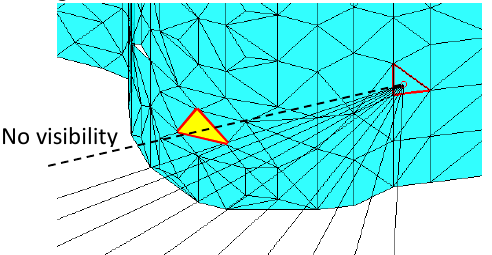
Figure 4. Visibility by testing the ray-triangle intersection